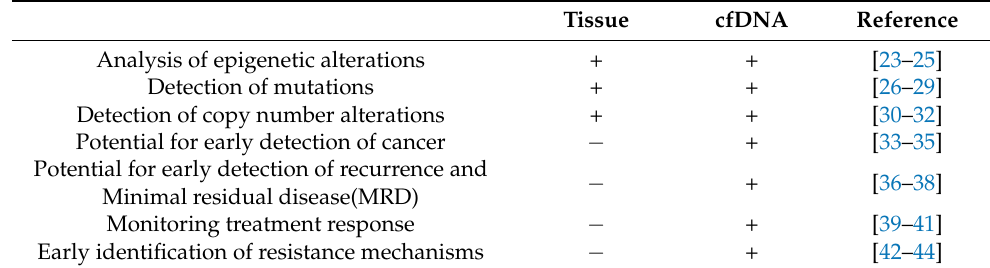
Table 1. Comparison of applications between tissue biopsy and cfDNA.